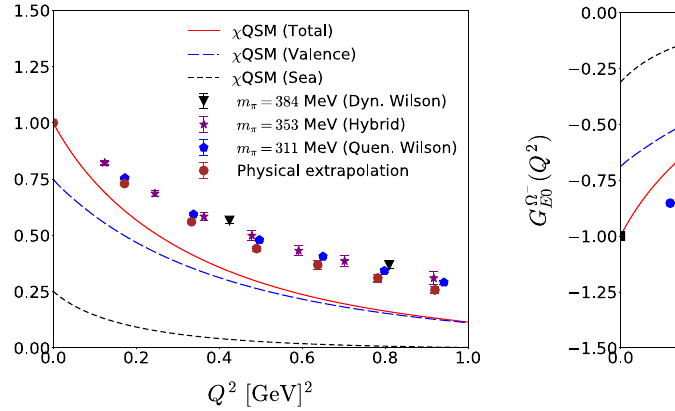
[21,23,24]. The data of the EM from factors of the (cid:2) + can be found be found in Ref.